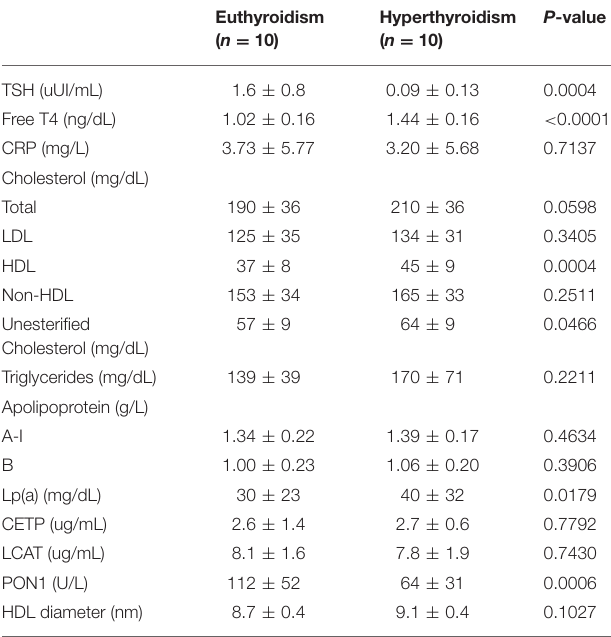
TABLE 1 | Thyroid and lipid metabolism parameters in euthyroidism and subclinical